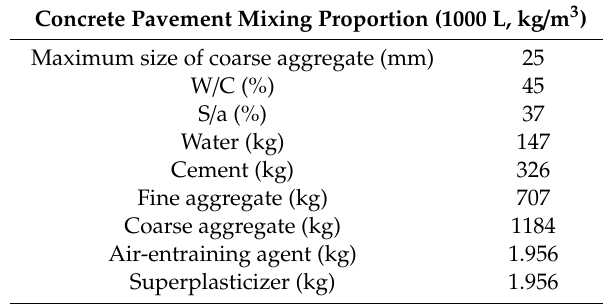
Table 1. Concrete pavement mixing